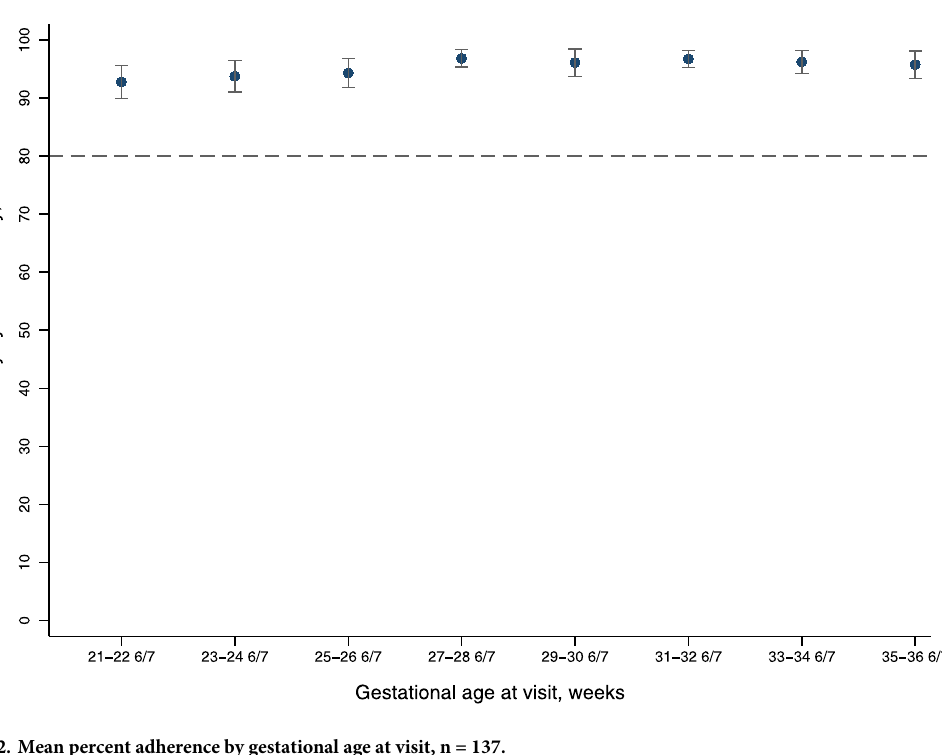
Baseline covariates associated with higher adherence determined by DSA in multivariable analysis included: having running water at home (coefficient 3.44; 95% CI 0.36–6.54) and parity (coefficient 1.40; 95% CI 0.32–2.48) (Table 4). Receipt of a new HIV diagnosis during the current pregnancy was marginally associated with lower adherence (coefficient -3.28; 95% CI -6.64–0.08). Retention was over 90% at each scheduled follow-up study visit (Fig 2). Of the 140 random- ized, 119 (85.0%) participants attended all scheduled visits, 14 (10.0%) participants missed 1 scheduled visit, and the remaining 7 (5.0%) missed 2 or more visits. We were able to ascertain delivery outcomes (i.e., at minimum date of delivery and vital status of neonate at delivery) from 134 (96%) participants; 3 women from each randomization group (n = 6) were lost to fol- low-up. Higher baseline maternal BMI (OR 1.49; 95% CI 1.06–2.08) and higher hemoglobin (OR 1.96; 95% CI 1.00–3.85) were each associated with retention at the delivery visit (Table 5).